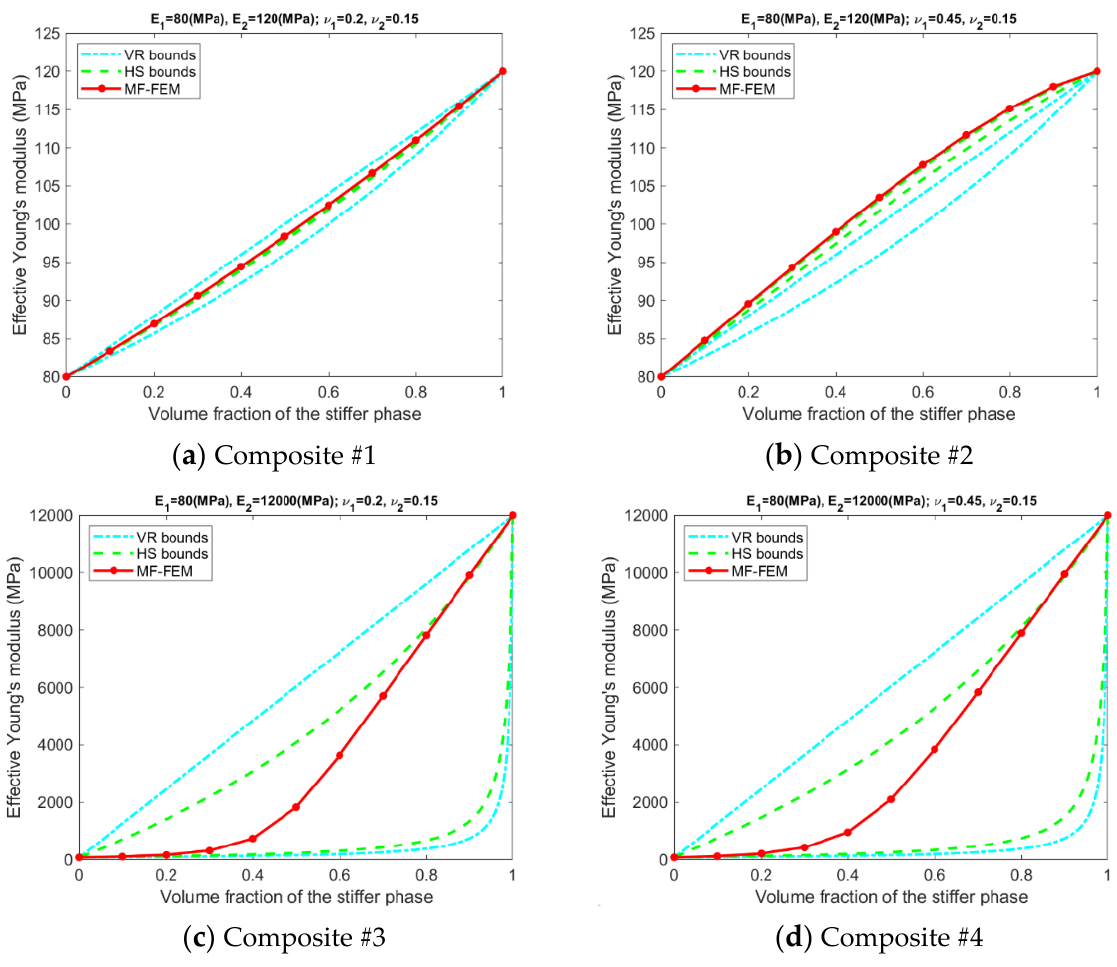
Figure 3. MF-FEM predictions and VR/HS bounds of effective Young’s modulus.